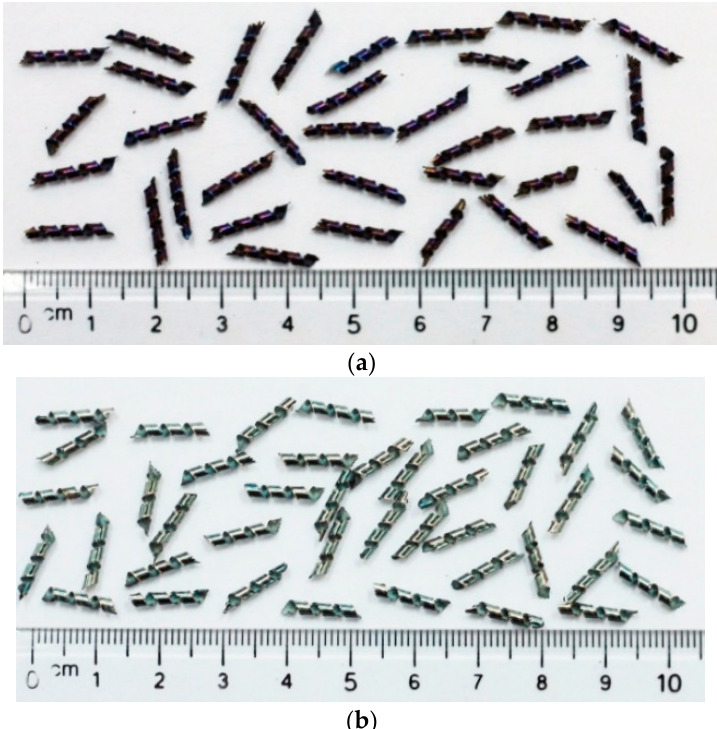
Figure 5. Chip morphology in conventional machining ( a ) and thermal-assisted machining ( b ) which were conducted using an MC500 milling machine.